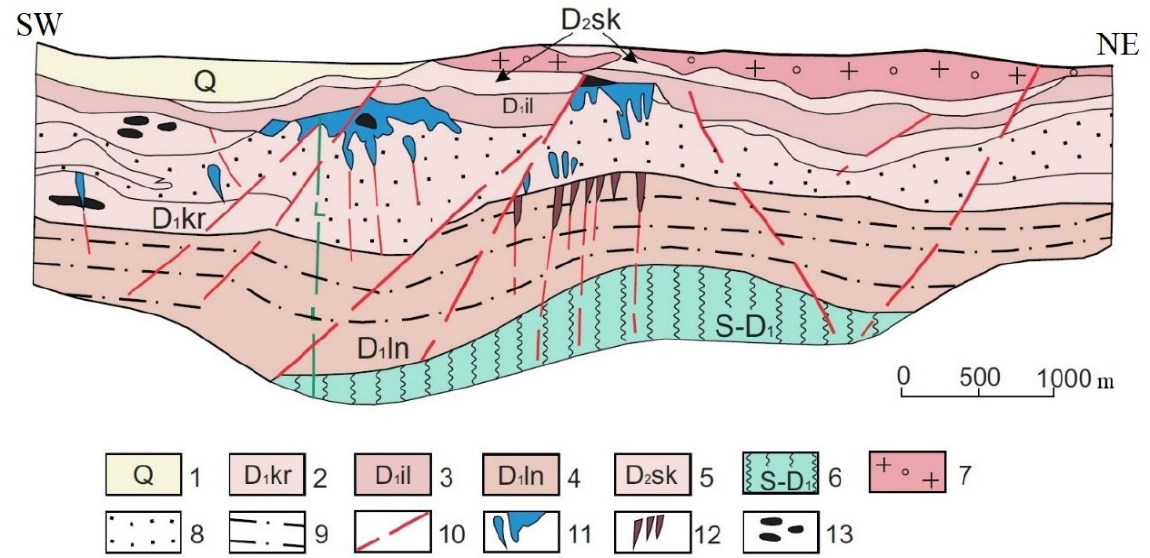
Figure 3. Cross section of southwestern Ridder ‐ Sokolny deposit. 1 = quaternary sediments; 2–5 = volcanic ‐ sedimentary formations: D 1 kr Kryukov Fm. siliceous and calcareous ‐ siliceous silty sand (2), D 1 il Ilyinka Fm. medium tuff and tuffite (3), D 1 ln Leninogorsk Fm. felsic lava and lava breccia (4), Sokolny Fm. carbonaceous ‐ argillaceous ‐ calcareous siltstone; 6 = Early Paleozoic schists; 7 = Middle Devonian granitoids; 8–13 = metasomatic rocks: sericitized microquartzte (8), microquartz ‐ ite (9), small gold ‐ sulfide ‐ quartz veins (10), orebodies (11), pyroclastic breccias (12), sericitized shale (13).